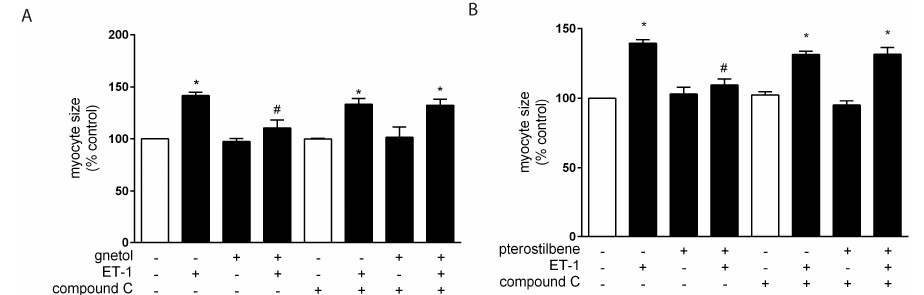
Figure 3. Chemical disruption of AMPK signaling attenuates gnetol and pterostilbene effects. Myocytes pre-treated with vehicle or compound C, a chemical inhibitor of AMPK, for 1 h, then exposed to gnetol or pterostilbene for 1 h, followed by addition of ET-1 (0.1 µM) for 24 h. Upon addition, all compounds remained in the culture media for the remainder of the experiment. Compound C abolished the ability of ( A ) gnetol (5 µg/mL); and ( B ) pterostilbene (1 µg/mL) to inhibit ET1-induced myocyte enlargement. n = 3. * p < 0.05 vs. control (open bars); # p < 0.05 vs. ET1.